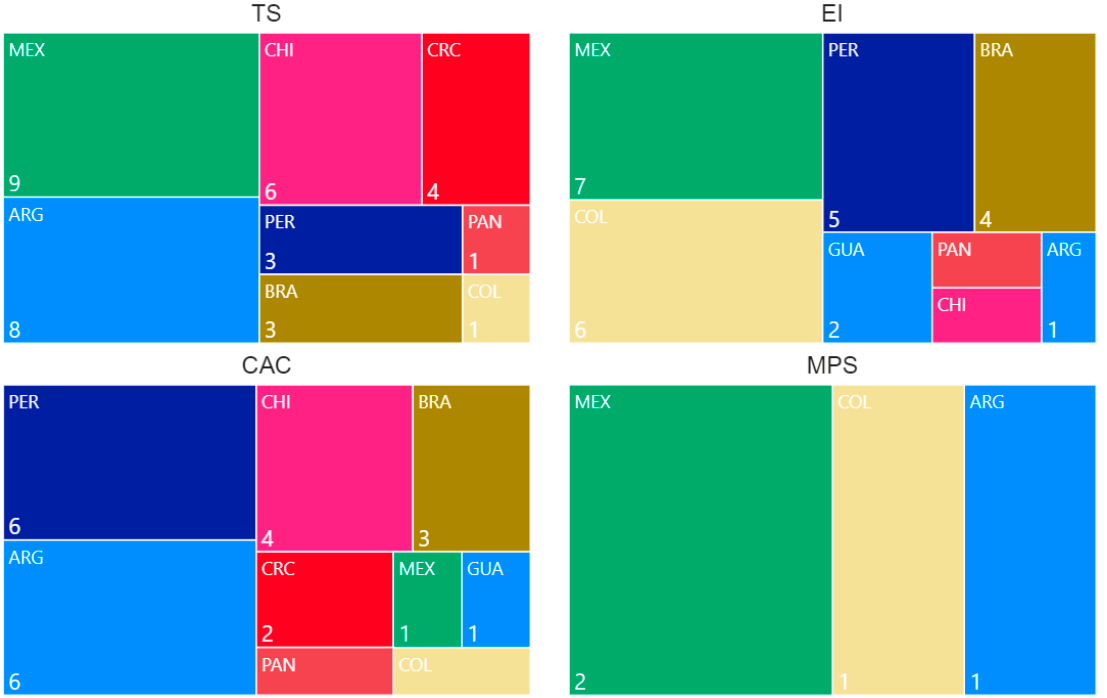
Figure A1. Map of the policies reviewed in this paper, framed according to our framework to classify green building regulations.